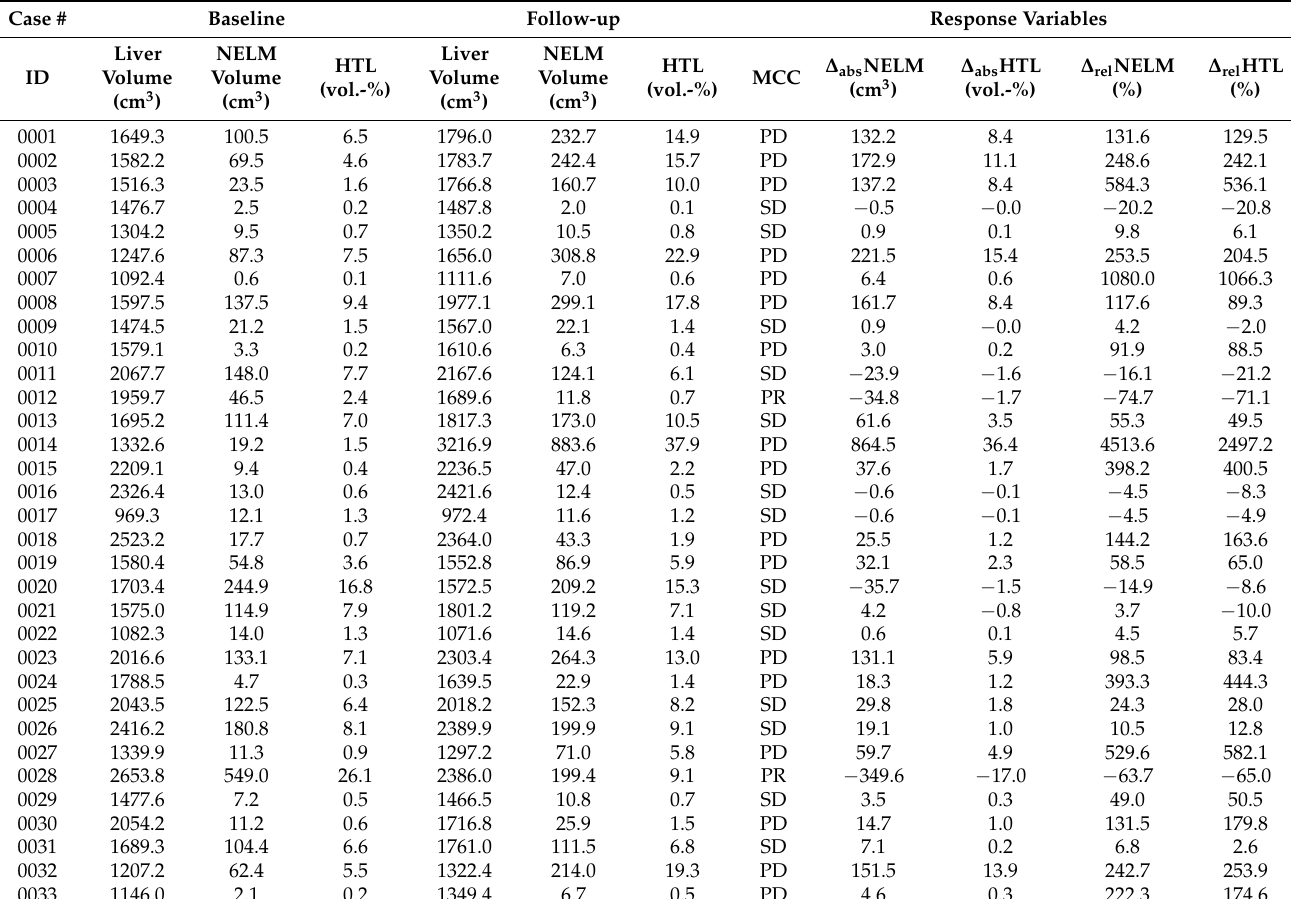
Table 3. Case-wise summary of the model’s measurements and response variables in the MCC